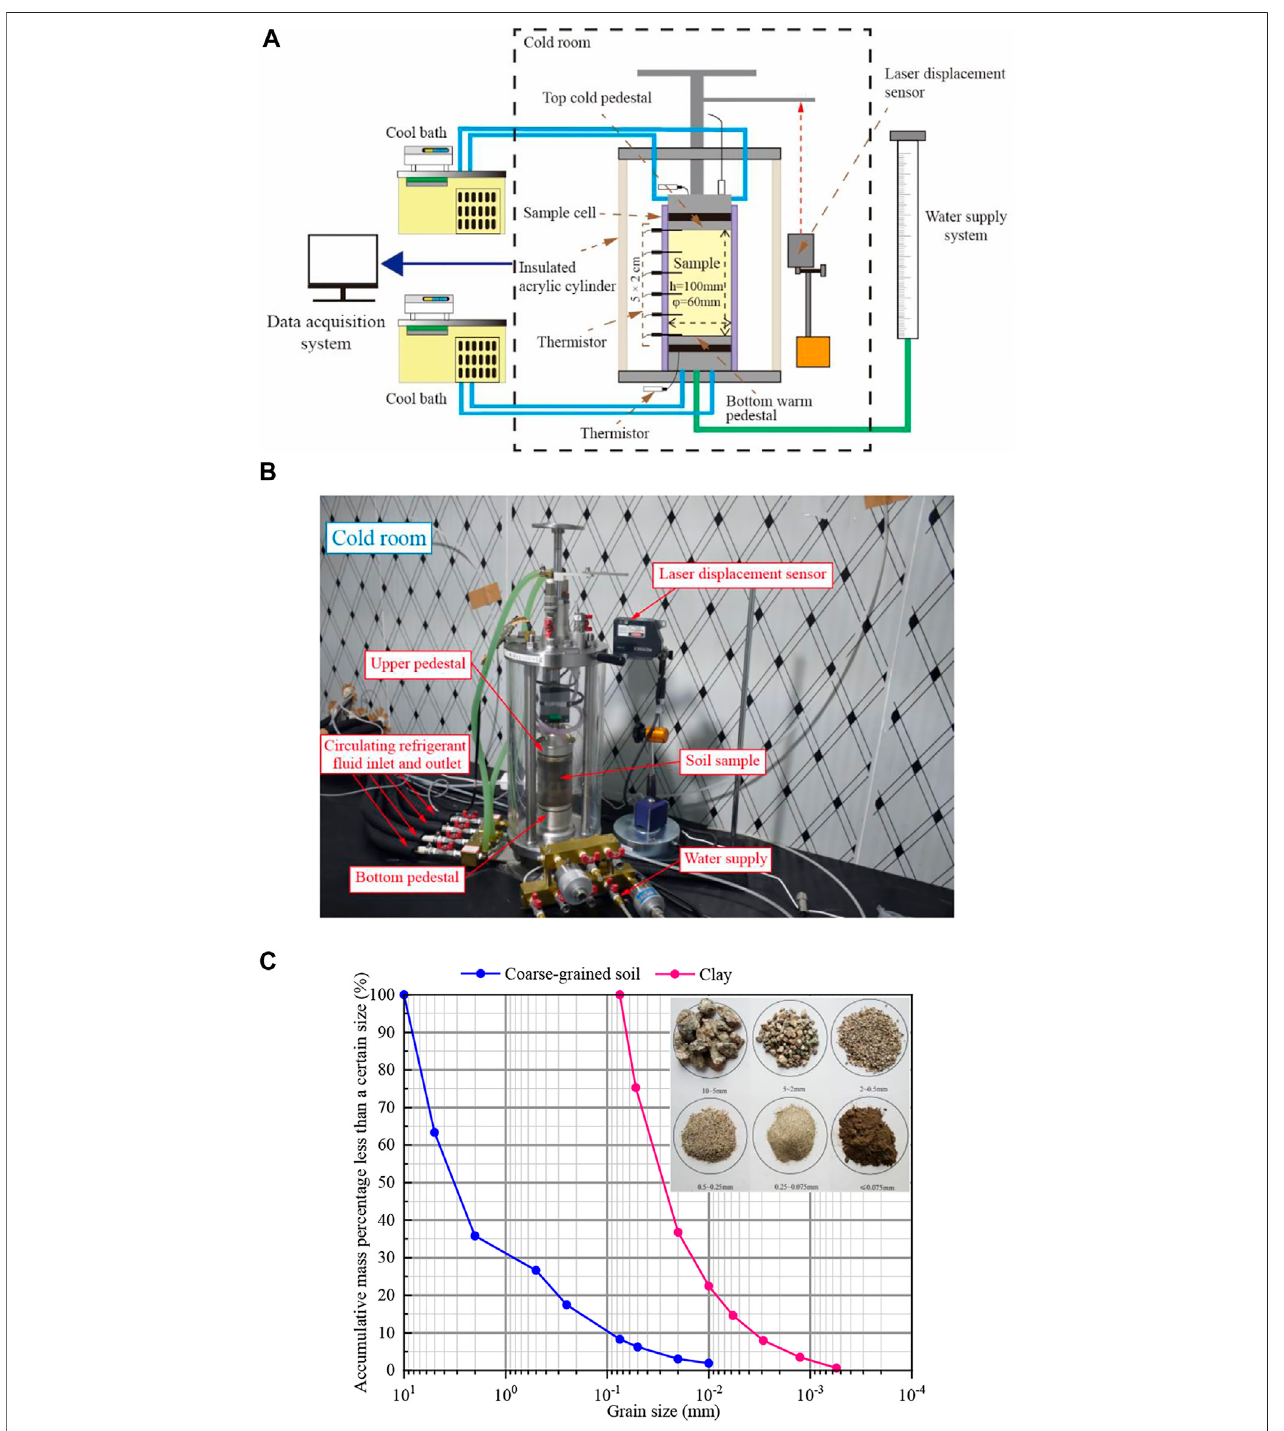
FIGURE 6 | | Frost heave test apparatus and samples. (A) Schematic diagram; (B) real test devices in the cold room; and (C) grain size distribution curves of samples.